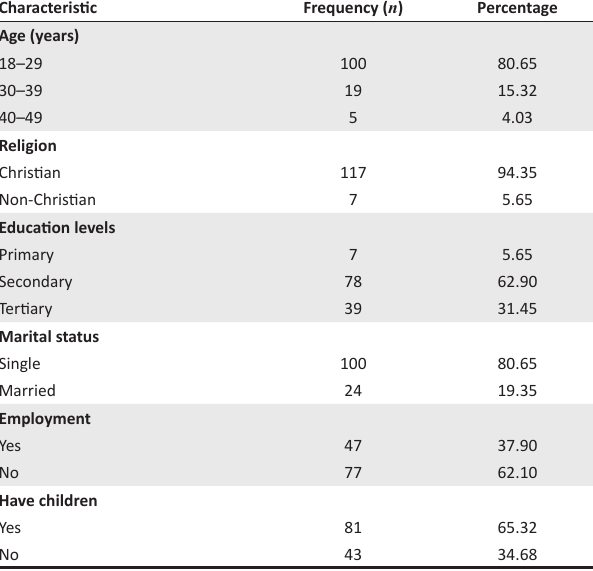
TABLE 1: Sociodemographic characteristics of the